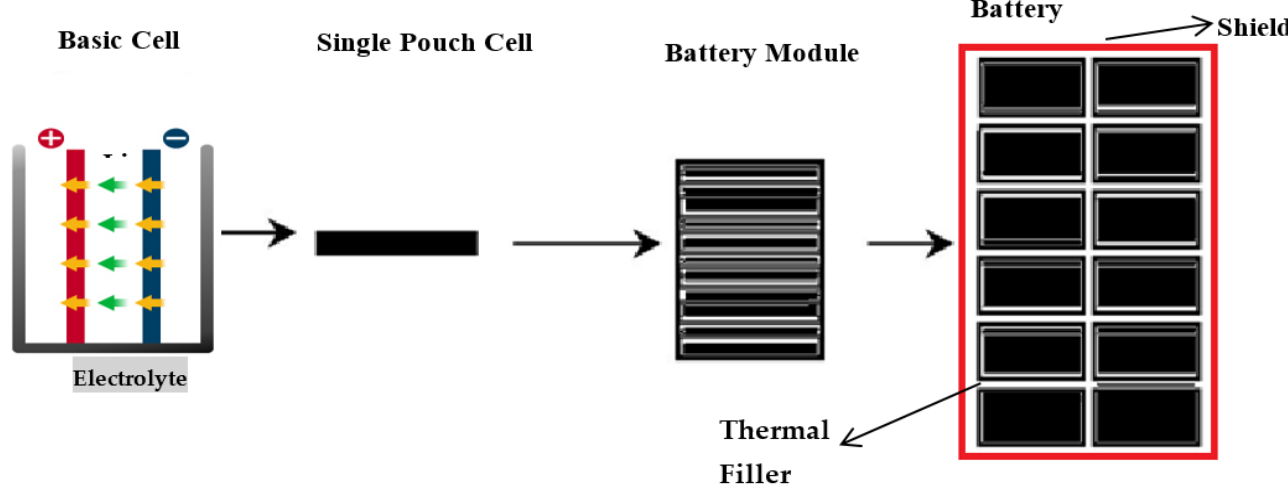
Figure 1. Preferable sketch of lithium-ion battery pack design and outer shield.